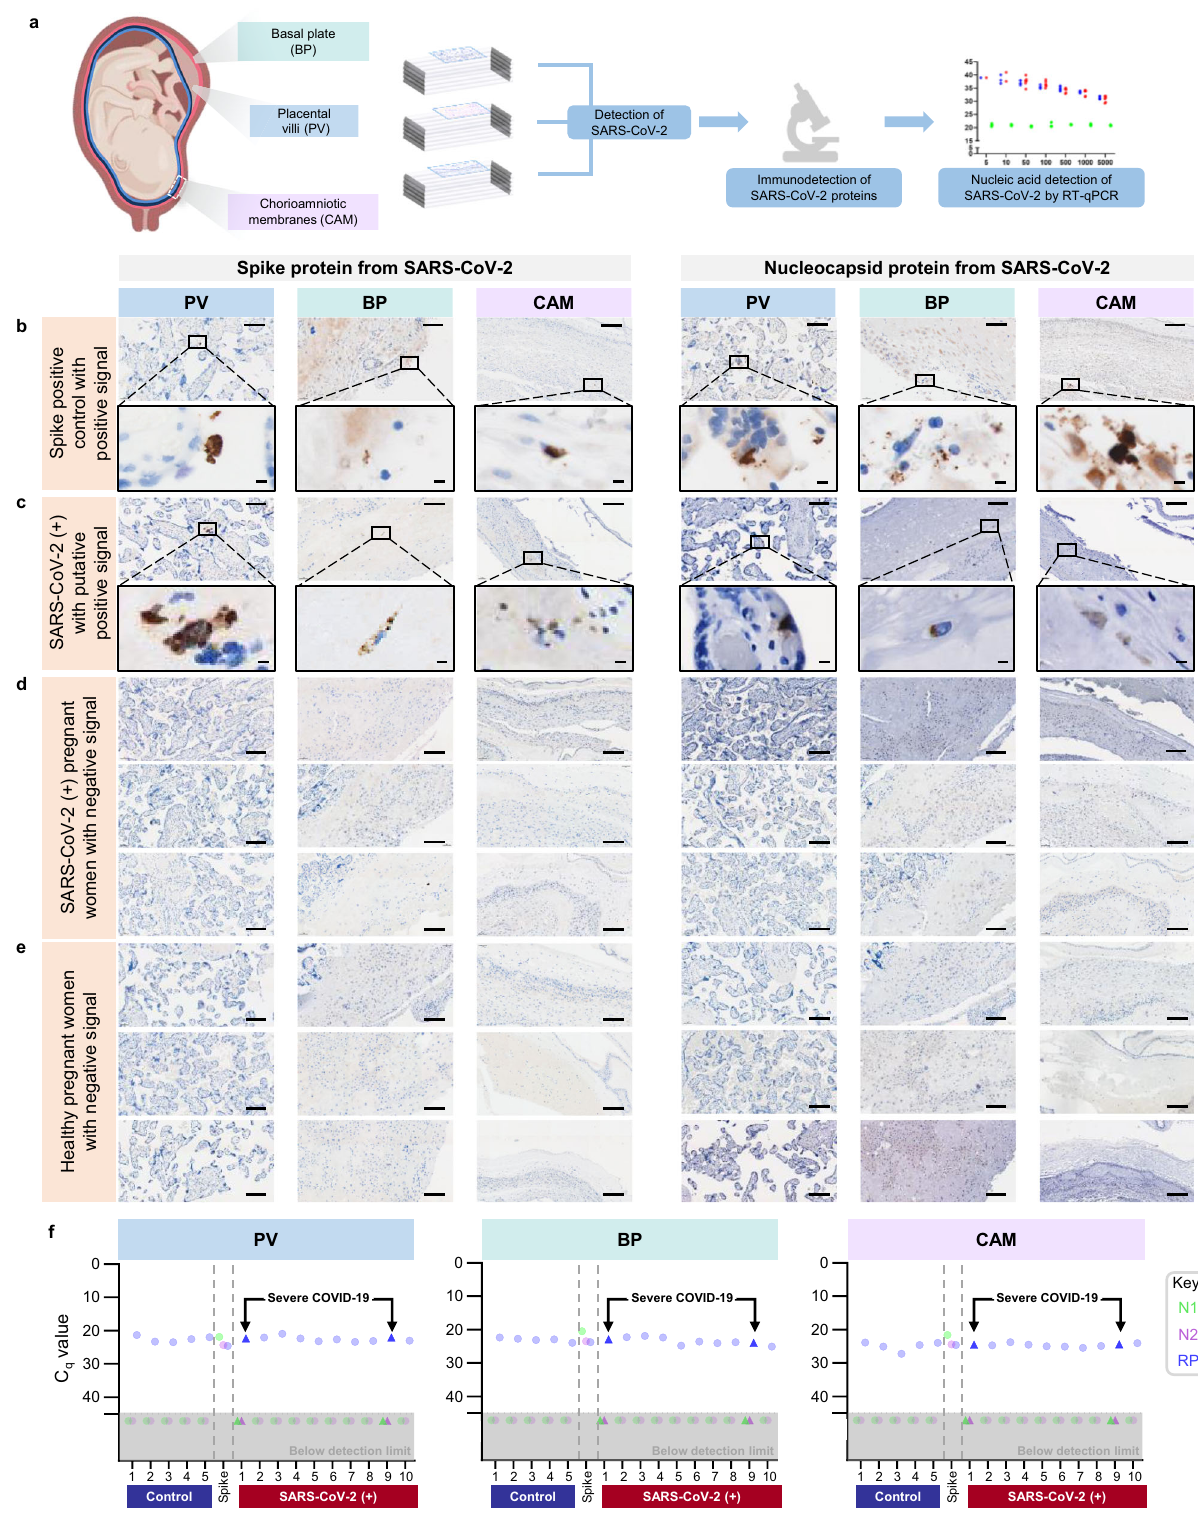
disc. Acute and chronic in fl ammatory lesions of the placenta (maternal in fl ammatory response and fetal in fl ammatory response), as well as other placental lesions, were diagnosed according to established criteria 83 , as shown in Supplementary Table